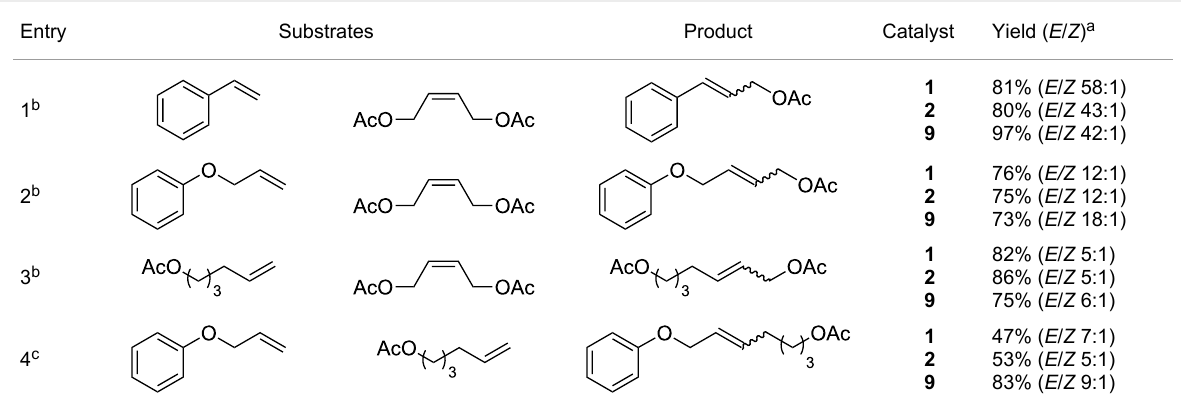
Table 2: Comparative investigation of the catalysts’ performance in CM reactions. Entry Substrates Product Catalyst Yield ( E / Z ) a